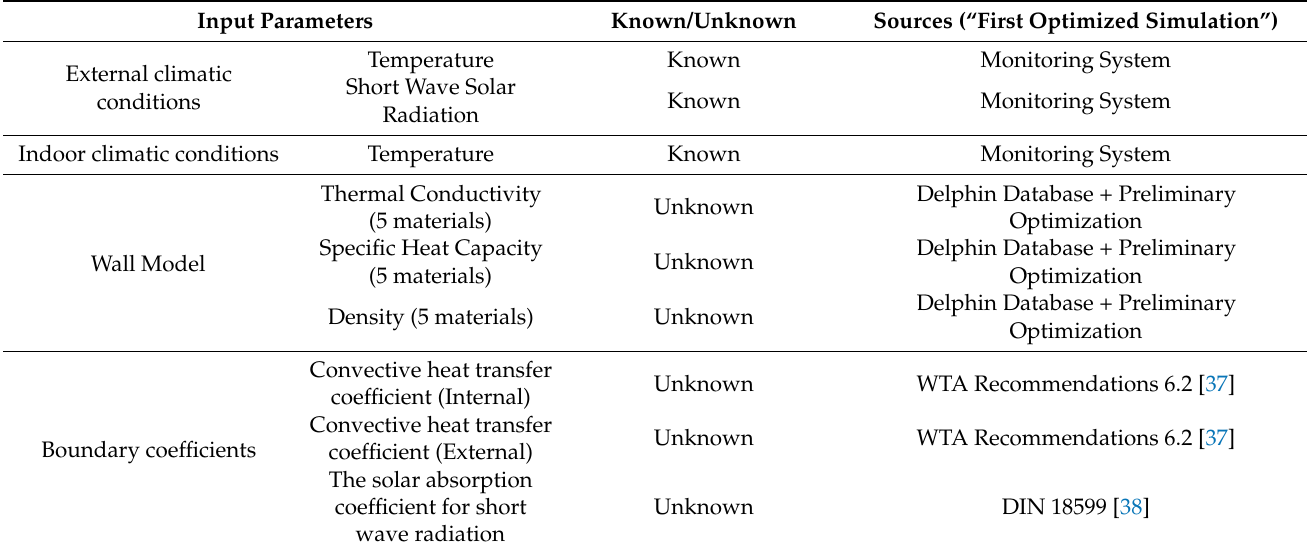
Table 1. Sources of the input values in the